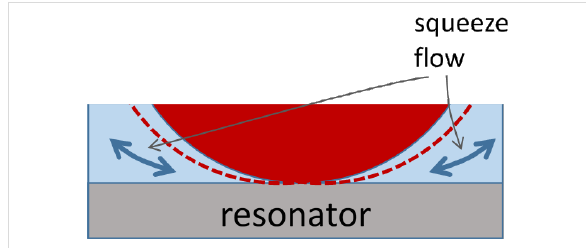
Figure 6: A sketch of an explanation for the increase in MHz contact stiffness when an experiment is undertaken in liquid rather than in air. A rocking motion of the sphere couples to a squeeze flow of liquid in the wedge next to the edge of the contact. Since inertia immobilizes the liquid, there is a significant amount of volume compression. The liquid responds elastically to